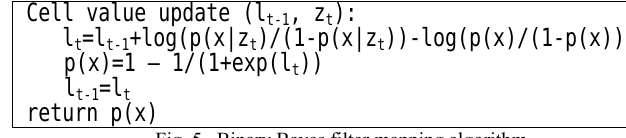
Cell value update (l t-1 , z t ): l